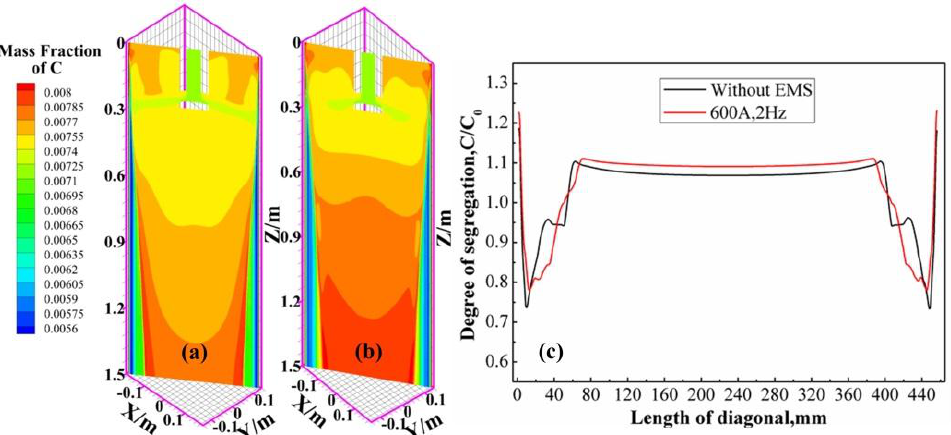
Figure 13. Distributions of solute element C on the diagonal plane (( a ) without EMS; ( b ) 600 A, 2